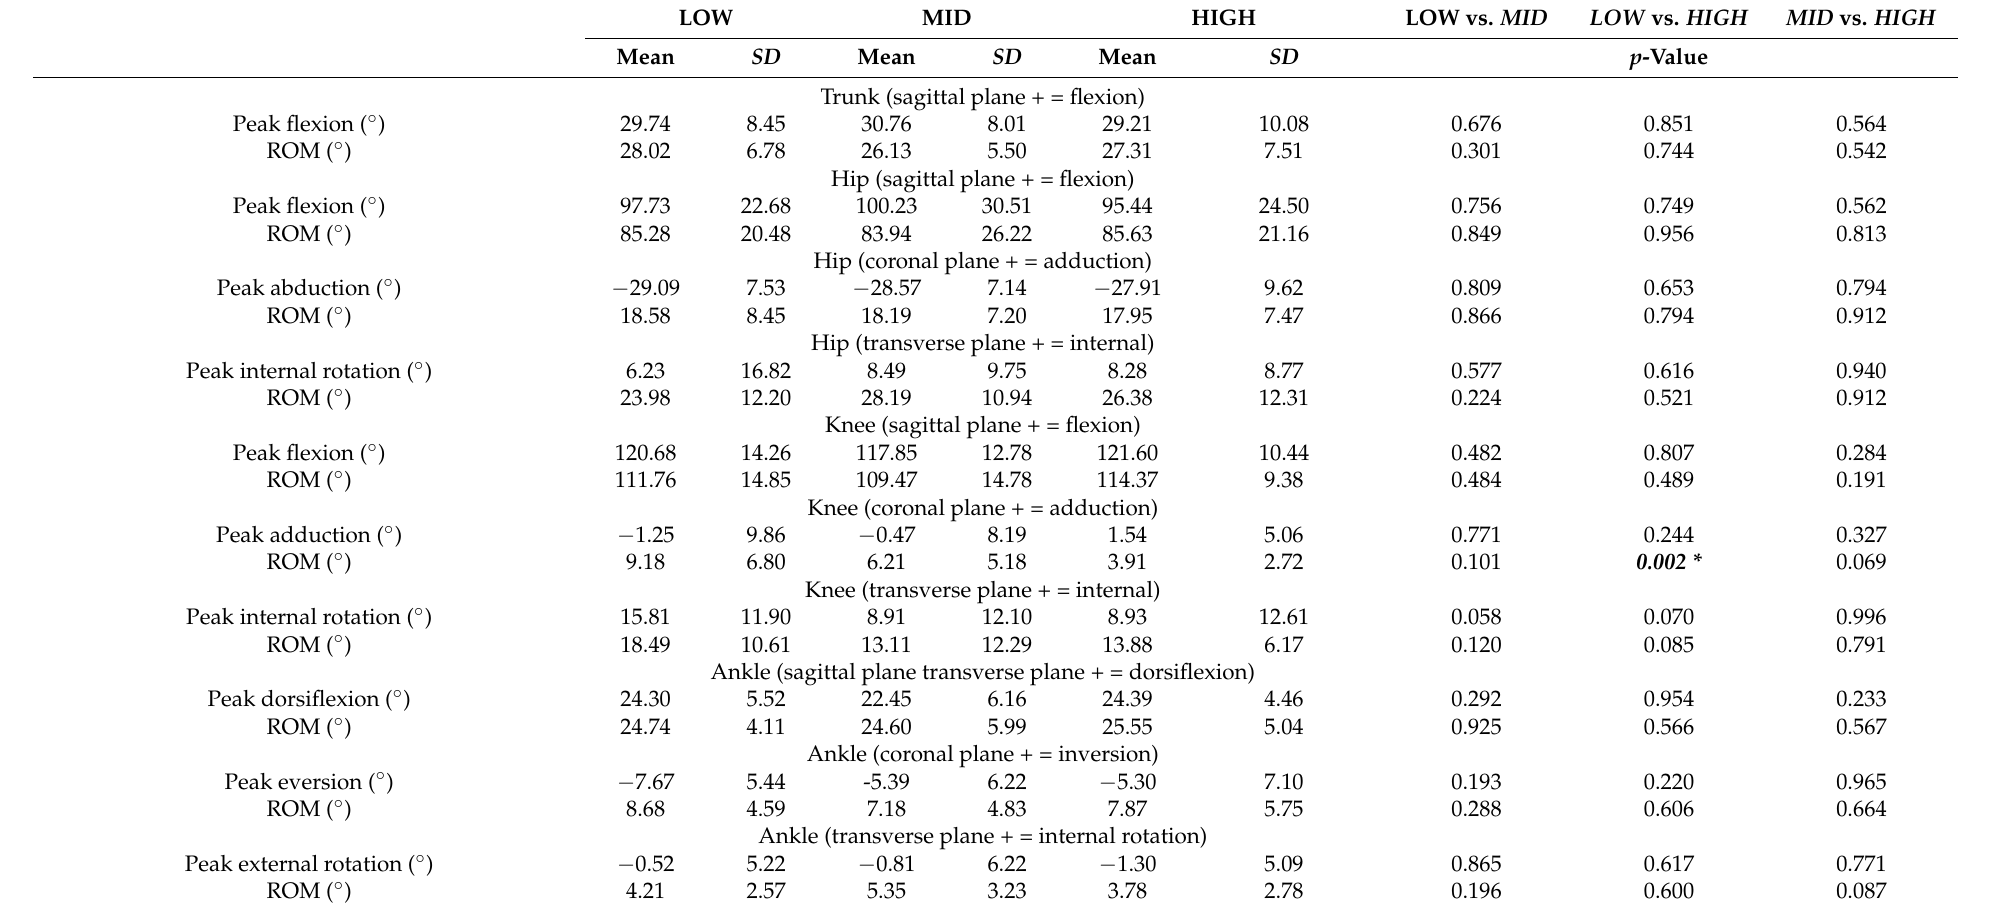
Table 3. Kinematic parameters (mean ± SD) and statistical comparisons as a function of each experimental group. LOW MID HIGH LOW vs. MID LOW vs. HIGH MID vs.